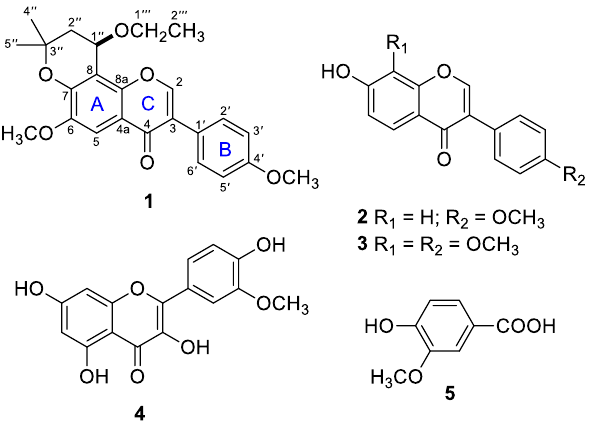
Figure 1. Chemical structures of 1 – 5 .